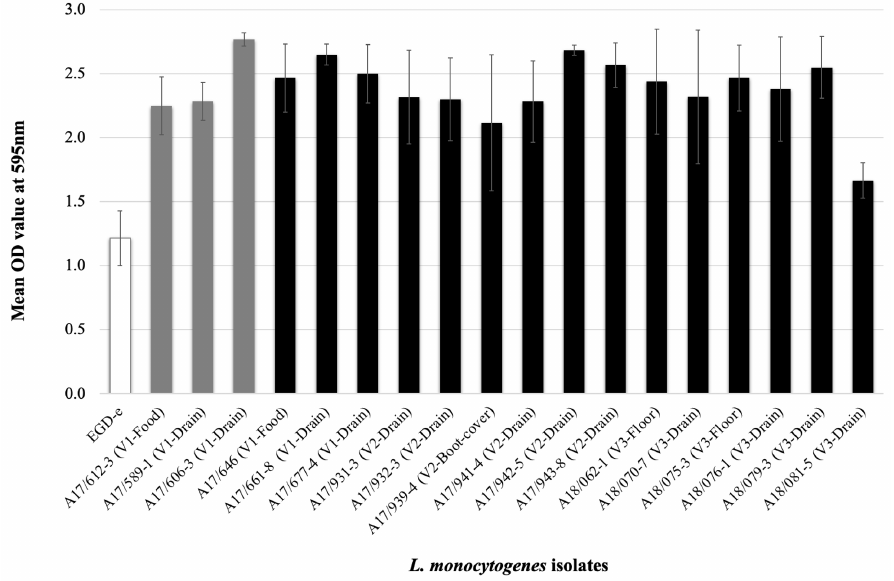
Figure 3. L. monocytogenes biofilm formation. Grey bars represent FSOp-A isolates, and black bars are FSOp-B isolates. L. monocytogenes EGD-e strain (serotype 1/2a) was used as a control.